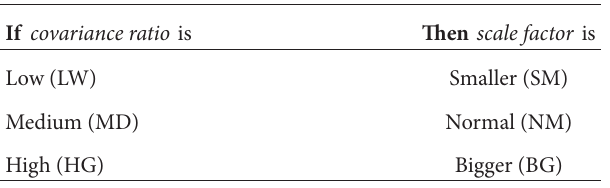
Table 2: Fuzzy rules for adaptive IKF.